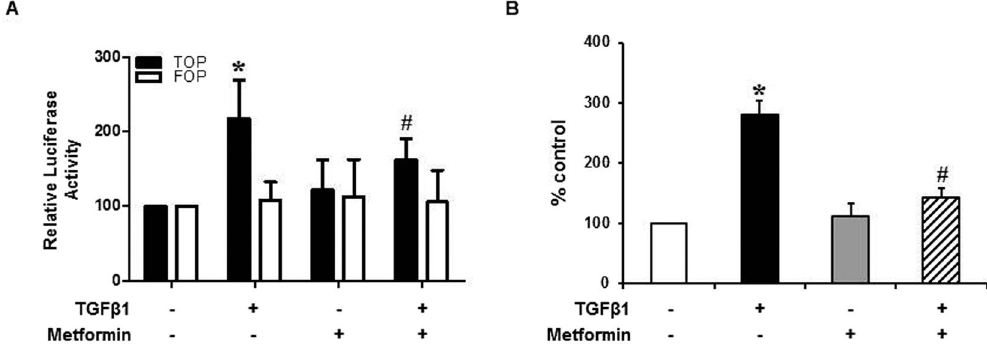
Figure 4. Effect of TGF- β and Metformin on β -catenin/TCF Transcriptional Activity. ( A ) Metformin exhibits a significant inhibitory effect against TOPflash reporter gene which was activated by TGF- β without affecting FOPflash activity (a mutant of the TCF binding site). Quantitation bar for relative Luciferase activity (n = 5) is shown. ( B ) Real-time PCR reveals the mRNA expression of matrix metalloproteinase (MMP)-7 is up-regulated by TGF- β 1 (2.8-fold increase, 24 hours), which is ameliorated by metformin (N = 6). * p < 0.05 vs. others, # p < 0.05 vs. TGF- β